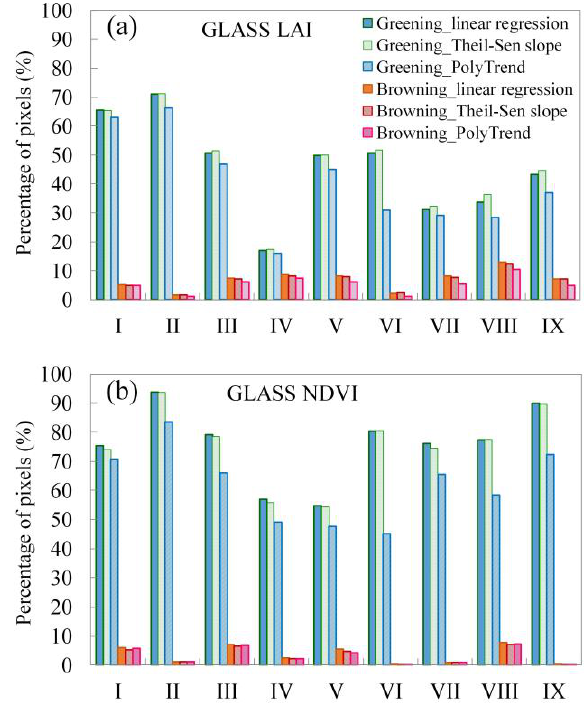
Figure 5. Percentage of cropland pixels with greening and browning in nine major Chinese agricultural zones from 1982 to 2015: percentages of cropland pixels with ( a ) GLASS LAI and ( b ) GLASS NDVI increasing and decreasing trends, detected by simple linear regression, Theil-Sen slope, and PolyTrend.